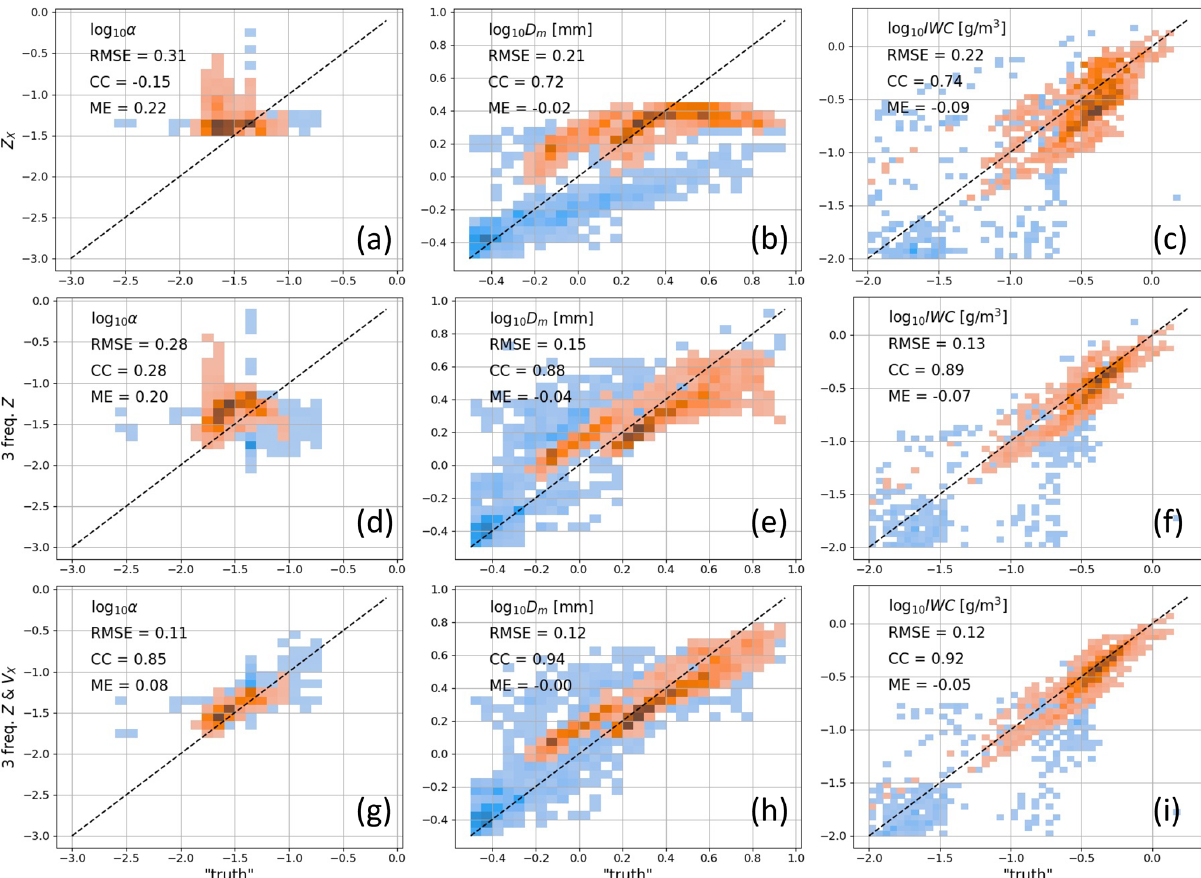
Figure 5. Histograms of in situ measurements ( x axis) collected during the RadSnowExp campaign and the retrieved ( y axis) microphysical parameters. Different columns correspond to different microphysical properties, i.e. log 10 α rm , log 10 D m and log 10 IWC. The rows corre- spond to different combination of radar measurements: single-frequency reflectivity, triple-frequency reflectivity and triple-frequency re- flectivity with Doppler data. The blue pixels represent the data along the whole flight, while the red ones represent measurements where Z X > − 20dBZ, DWR X − Ka > 1dB, DWR Ka − W > 1dB and the IWC is at least 70% of the total water content. The bulk statistics shown in the top left corner of each panel correspond to the red